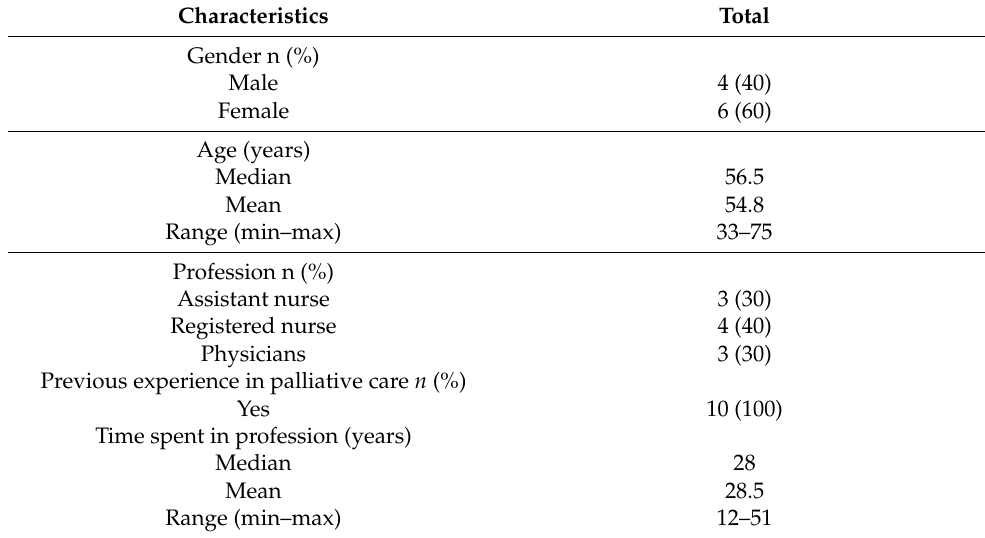
Table 1. Background